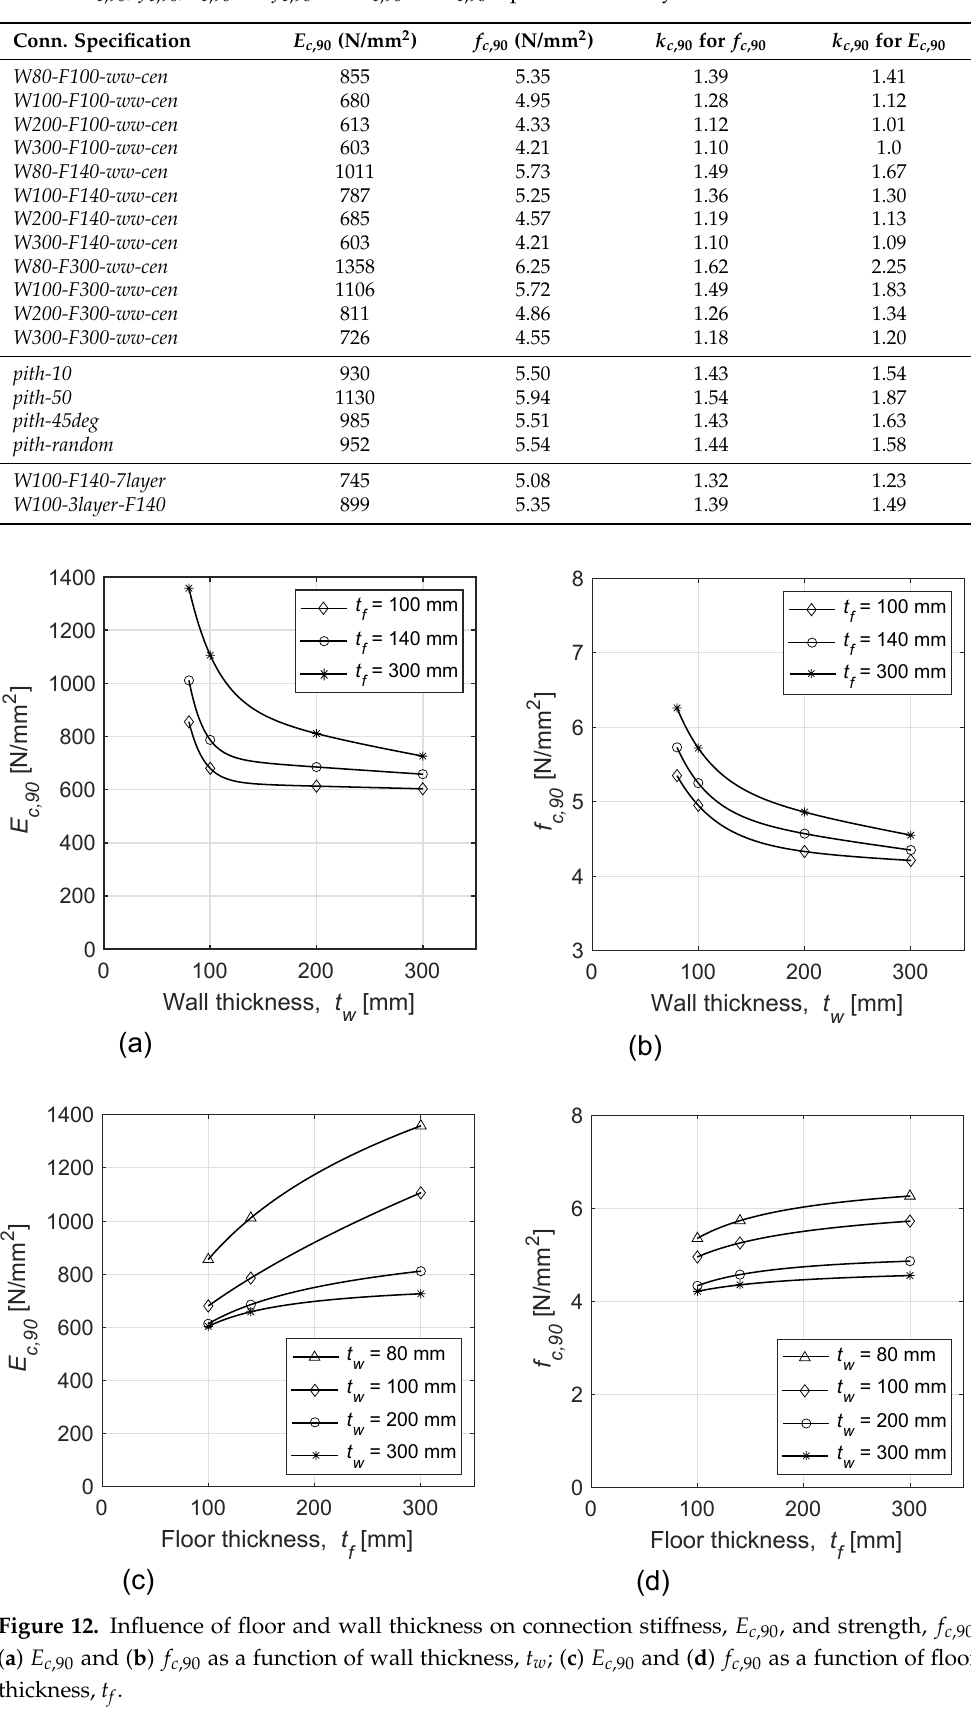
Table 6. E c ,90 , f c ,90 , k c ,90 for f c ,90 and k c ,90 for E c ,90 —parameter study.